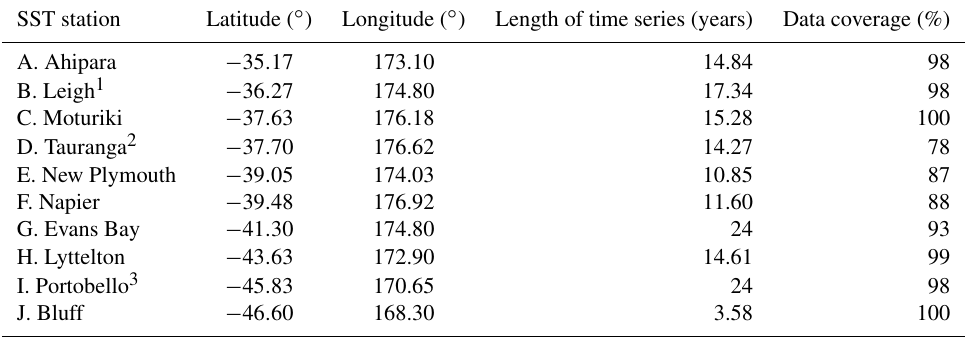
Table 3. Coastal daily surface temperature measurement station names, locations and data coverage, where percentage represents the duration of the Moana Ocean Hindcast period. Measurement stations are maintained by NIWA, except where noted.